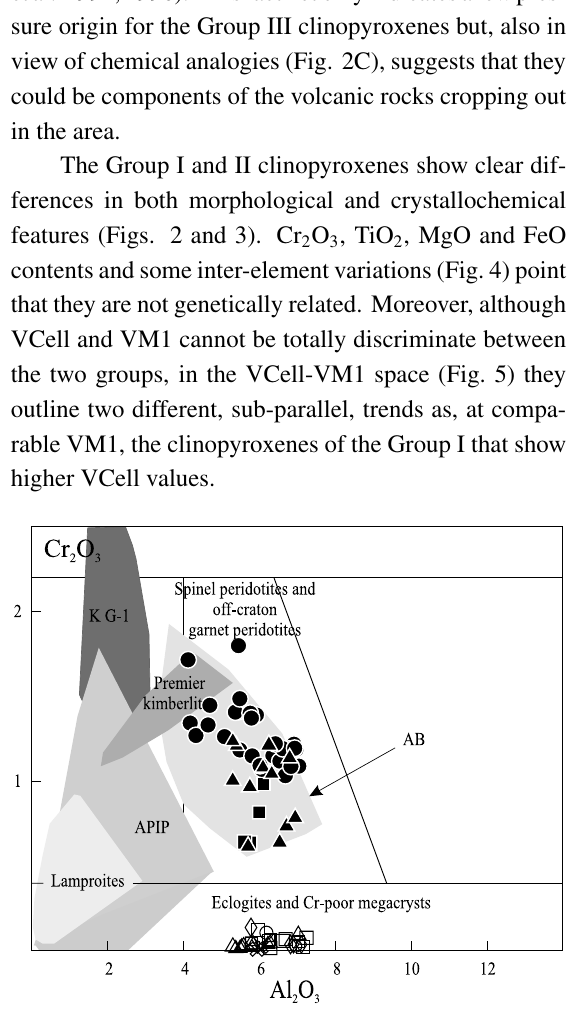
Fig. 3–Al 2 O 3 vs. Cr 2 O 3 forclinopyroxenesfromtheJanjão,Pandolfo and Lambedor diatremes (after Nimis 1998, modified). 2. Premier kimberlites field after Grégoire et al. (2005). AB: clinopyroxenes from Sp-, Sp+Grt and Grt- peridotites from alkali basalt-like magmas after Princivalle et al. (1989, 2000), Ionov et al. (1993) and Kempton et al. (1999). Symbols and references as in Fig.